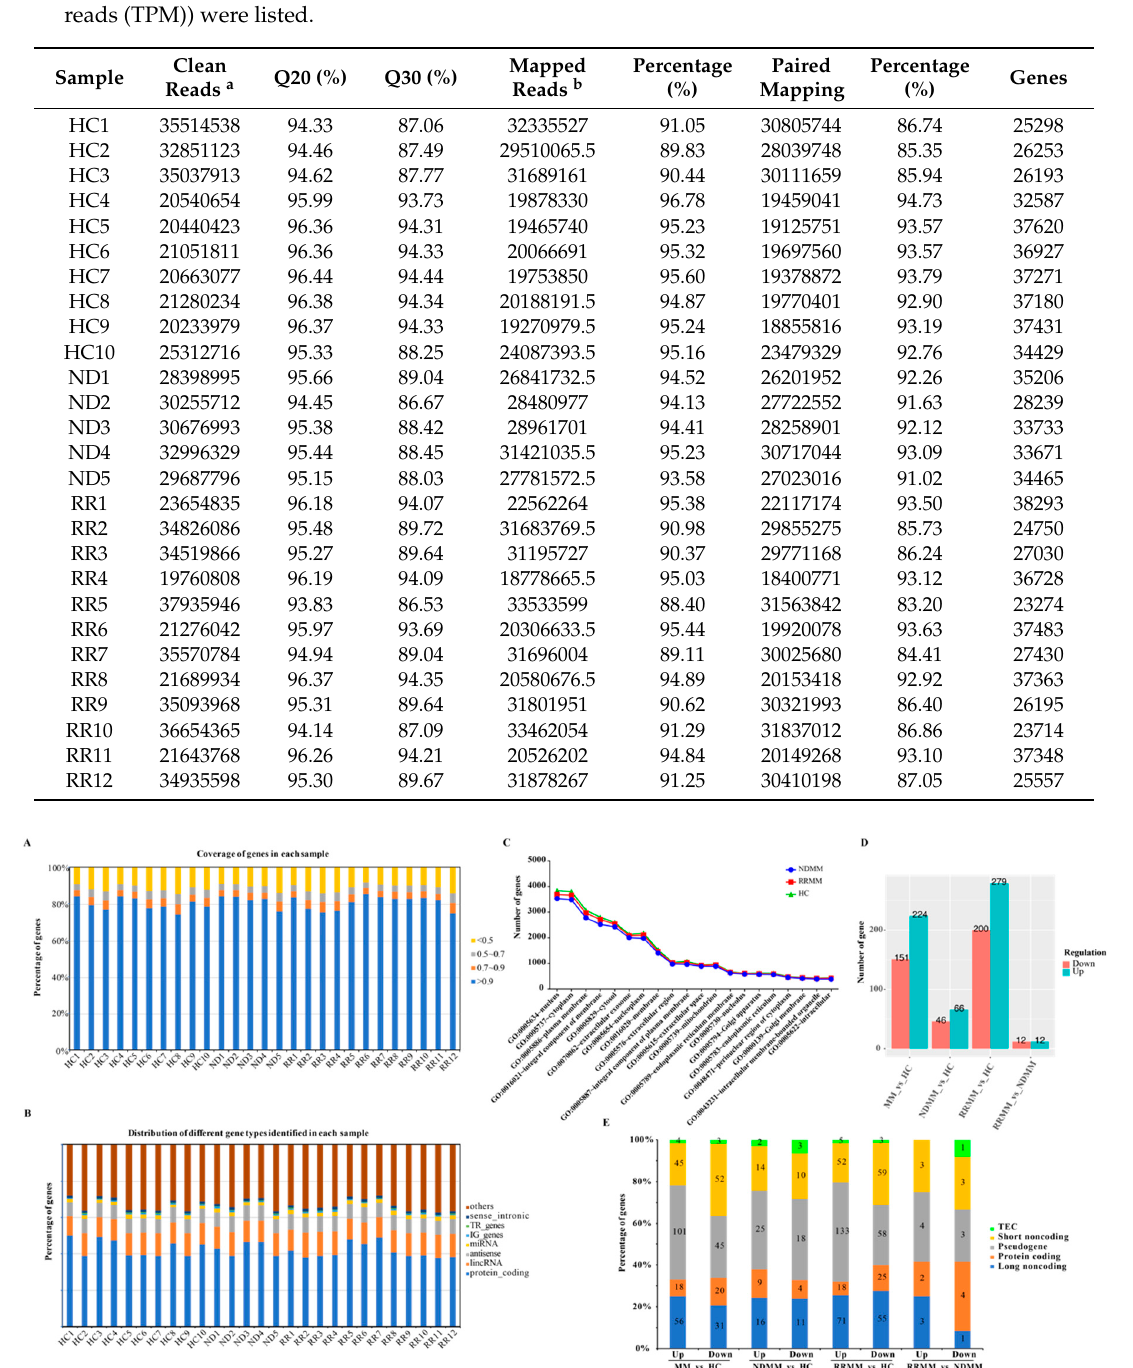
Figure 1. Overview of the transcriptome of extracellular RNA (exRNA) in healthy controls (HC) and multiple myeloma (MM) patients. ( A ) Distribution of gene coverage in each sample. ( B ) Distribution of gene types in each sample. ( C ) Top 20 terms of the GO cellular component identified by the genes in HC, newly diagnosed multiple myeloma (NDMM), and relapsed and refractory multiple myeloma (RRMM). ( D ) Status of differentially expressed genes identified in MM compared to HC. ( E ) Distribution of gene types for the differentially expressed genes (DEGs).